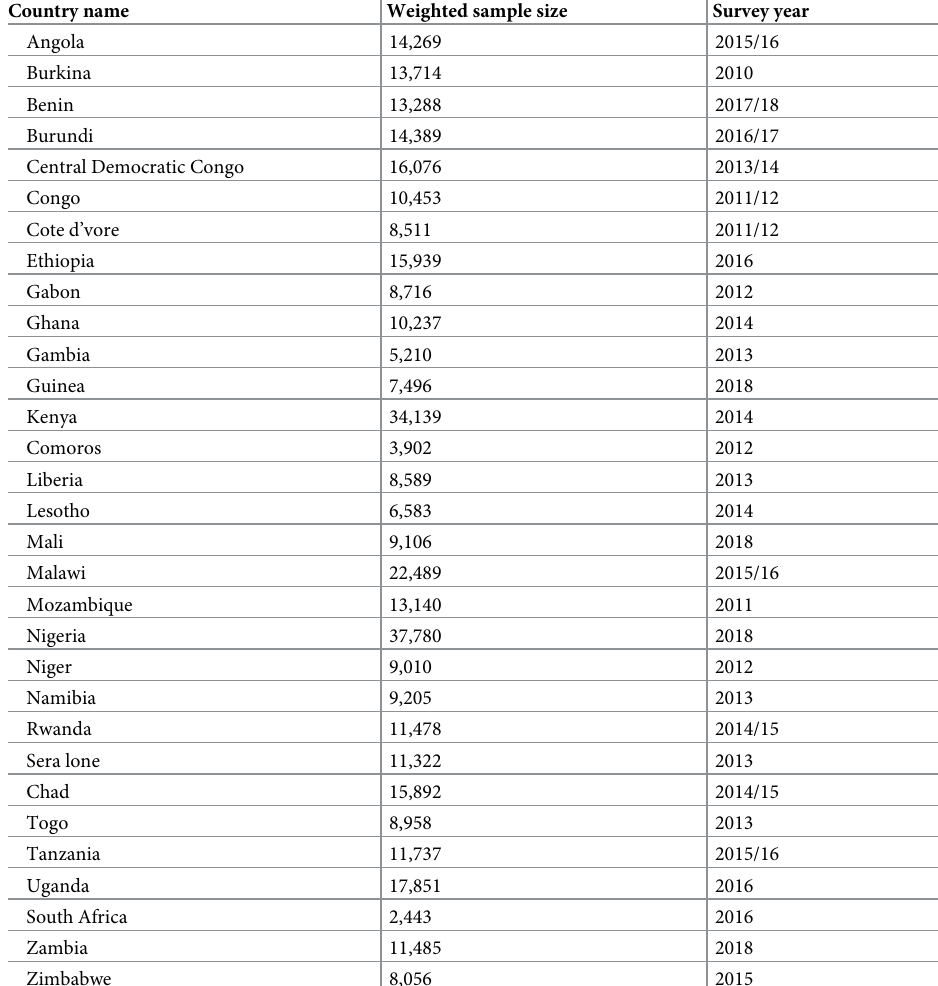
Table 1. List of countries sub-Saharan countries, their demographic and health survey year and sample size included in the